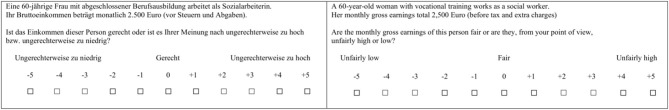
Example of a vignette with a rating scale used in population sample 1 and the student sample. The figure shows the German original version and the English translation by the author.